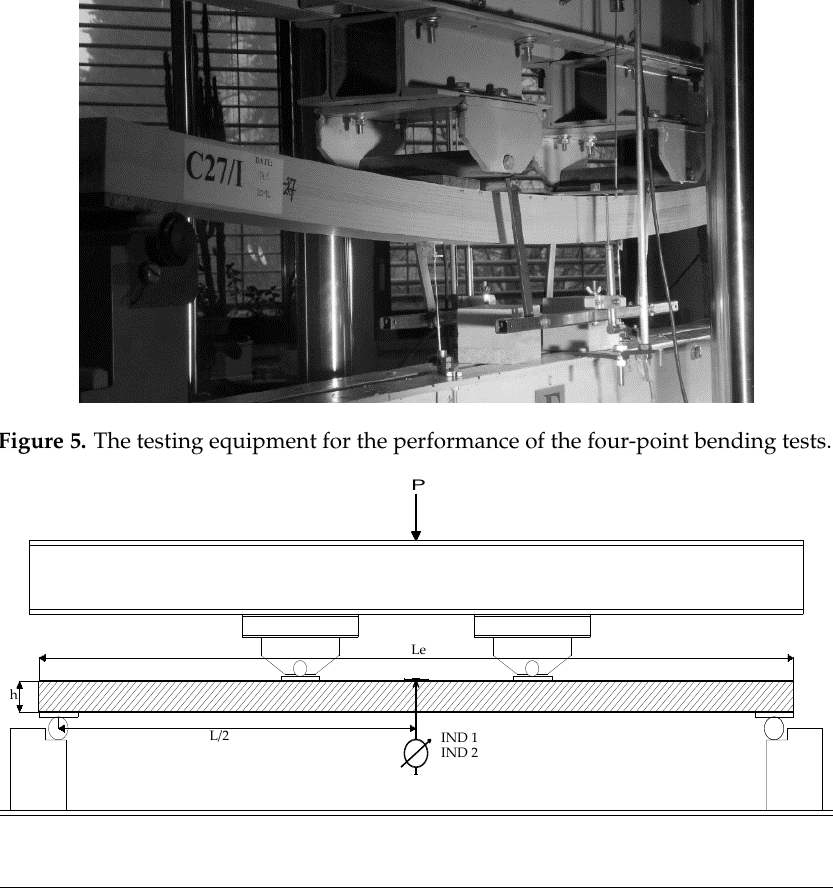
Figure 6. Basic configuration of the test instrumentation.